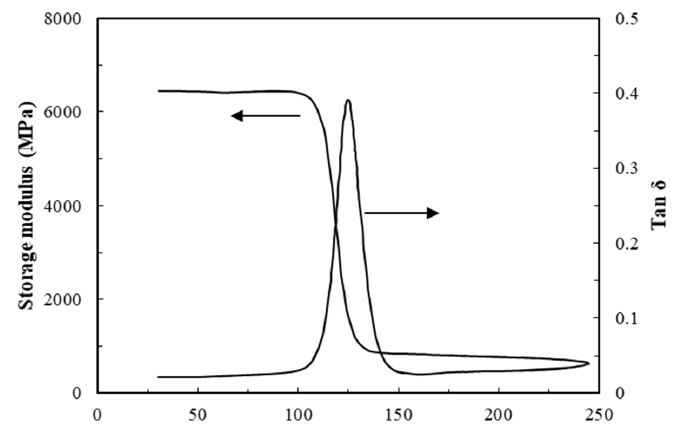
Figure 7. Dynamic mechanical properties of FFRP laminate.